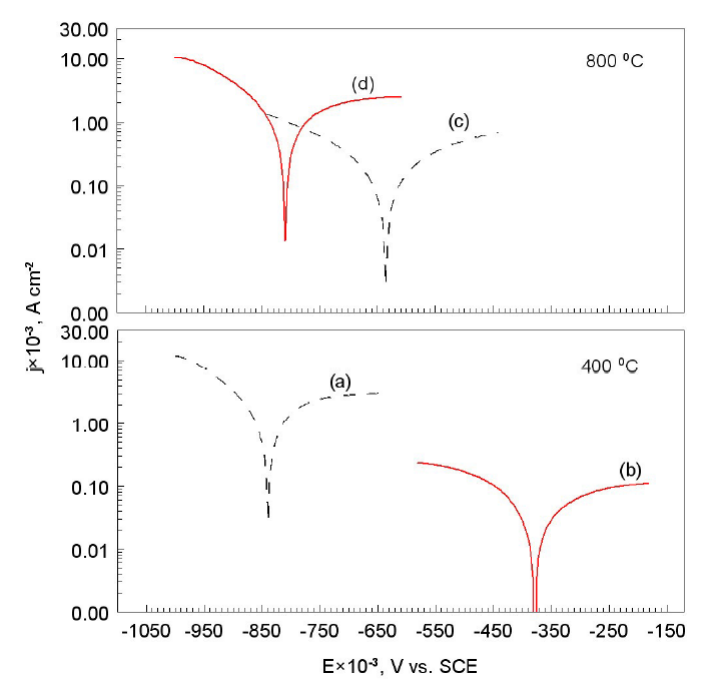
Figure 7. Potentiodynamic polarization curves (semilogarithmic scale) for the S355 steel, with and without DLC coating, after heat treatment in air atmosphere, at 400 and 800 ◦ C: ( a ) S355, ( b ) S355 / DLC, ( c ) S355, and ( d ) S355 / DLC. Solution contained: 1.2 M Cl − , and 0.2 M OH − , dE / dt 1 mV s − 1 , temperature 25 ◦